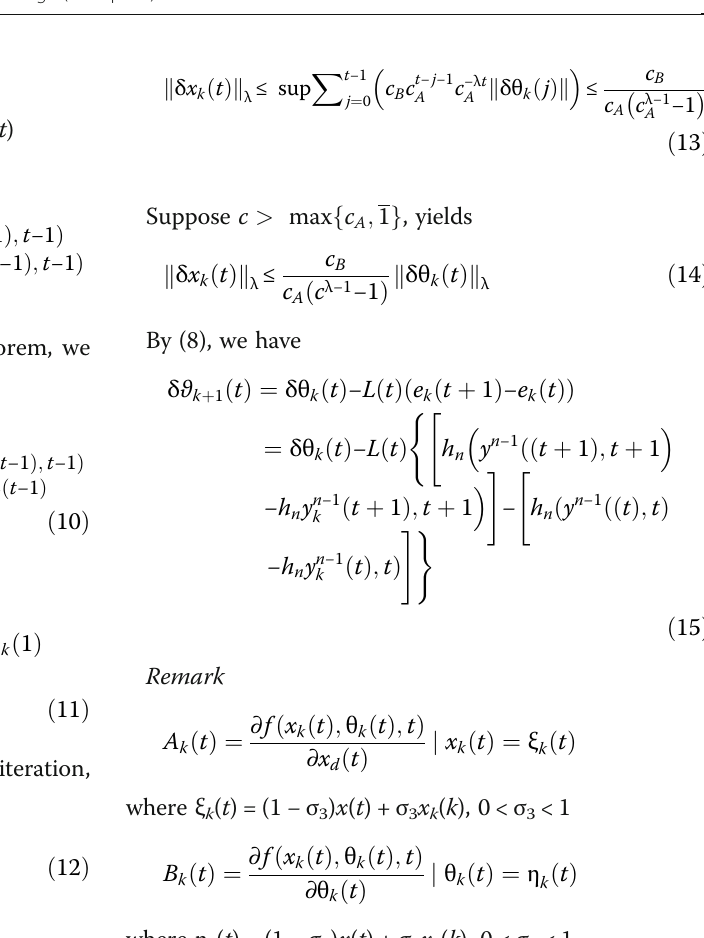
Fig. 10 Attacked with Gaussian noise and extracted hidden image (Example 1)